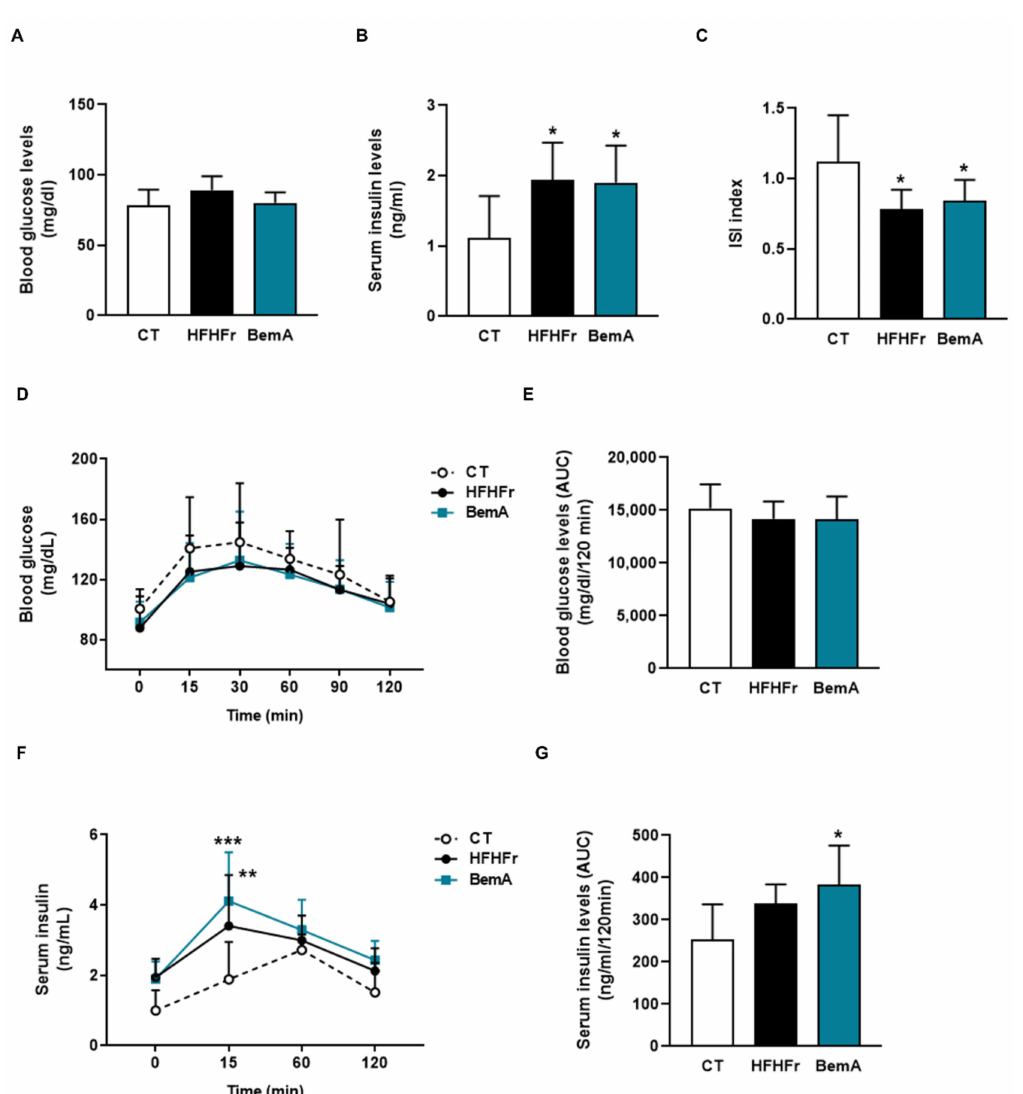
Figure 3. Bempedoic acid treatment does not correct the hyperinsulinemia induced by HFHFr. ( A ) Blood glucose and ( B ) serum insulin levels in control (CT), high-fat, high-fructose (HFHFr), and bempedoic acid (BemA)-treated rats at the end of the treatment. ( C ) Insulin sensitivity index (ISI) calculated as 2/[insulin (nM) X blood glucose ( µ M) + 1] in CT, HFHFr, and BemA rats. ( D ) Blood glucose levels and ( F ) serum insulin levels at different times after the glucose challenge in the oral glucose tolerance test, and the corresponding areas under the curves calculated from these values ( E , G ). The results are expressed as the mean ± SD of 7–8 animals/group. Data were analyzed by one-way ANOVA, followed by Tukey’s post-hoc test or by two-way ANOVA ( D , F ). * p < 0.05, ** p < 0.01, *** p < 0.001 compared to